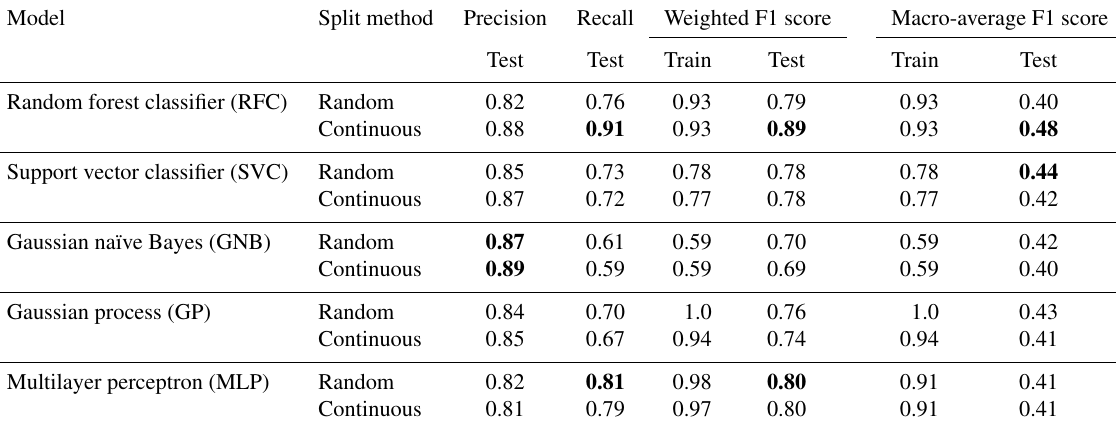
Table 4. Results for each model trained with the local dataset obtained from two local power grid companies (defined in Sect. 3.3). The results with boldfaced font represent the best achieved results within the metric, shown separately for the random and continuous split methods. Model